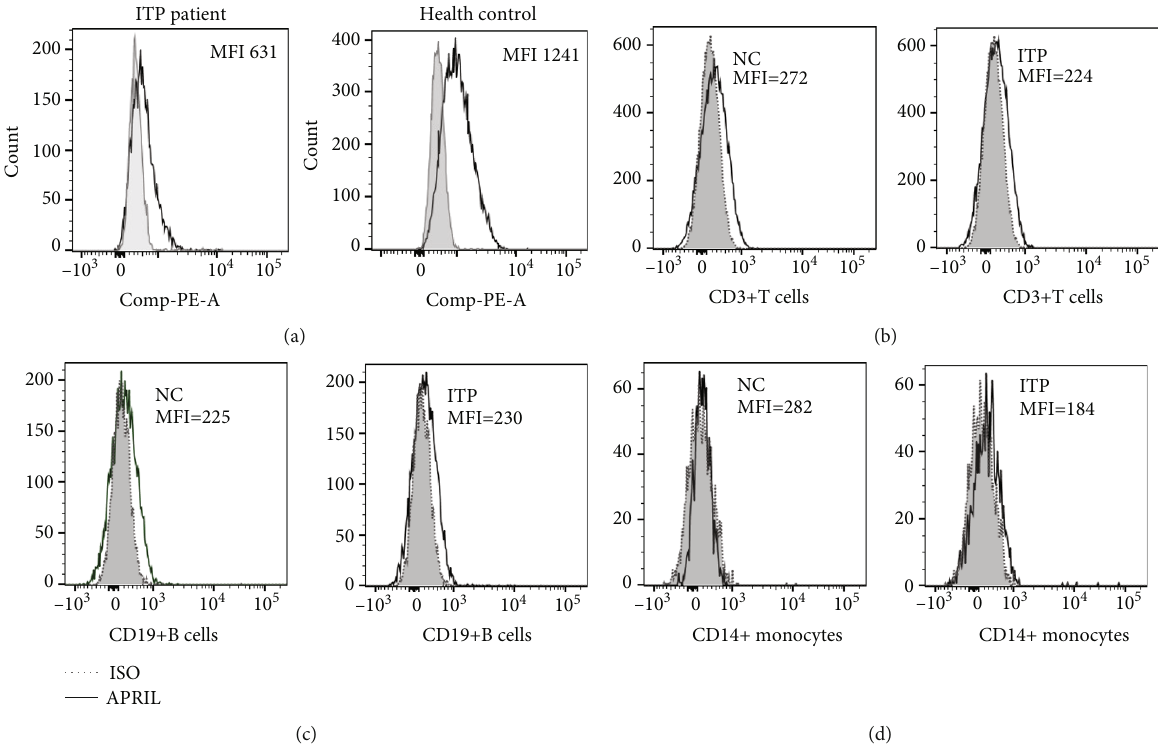
Figure 1: Representative histograms show surface APRIL and isoform staining of platelets (a), B cells (b), T cells (c), and monocytes and the NR group ( 11 : 28 ± 1 : 846 vs. 12 : 19 ± 1 : 215 , n = 8 , P = 0 : 6876 ) (Figures 3(e) and, 3(f)).